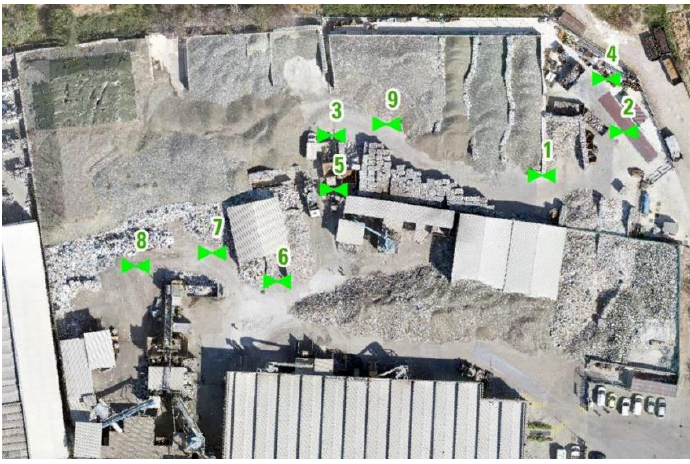
Figure 10. The survey area and the position of targets used as GCPs and CPs.